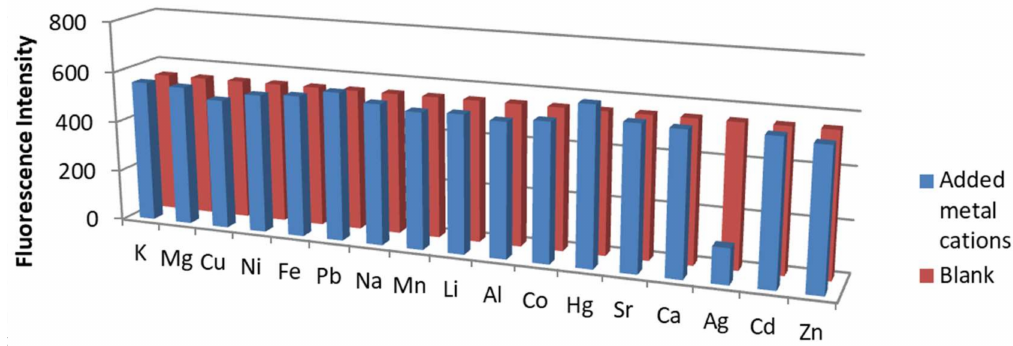
Figure 2. Fluorescence response of N -(Rhodamine-B)lactam-ethylenediamine (10 − 4 M) at 538 nm ( λ ex = 500 nm) as a function of various added metal cations (10 − 3 M) in aqueous solution of 100 mM phosphate buffer (pH 7). From left to right: K + , Mg 2+ , Cu 2+ , Ni 2+ , Fe 2+ , Pb 2+ , Na + , Mn 2+ , Li + , Al 3+ ,